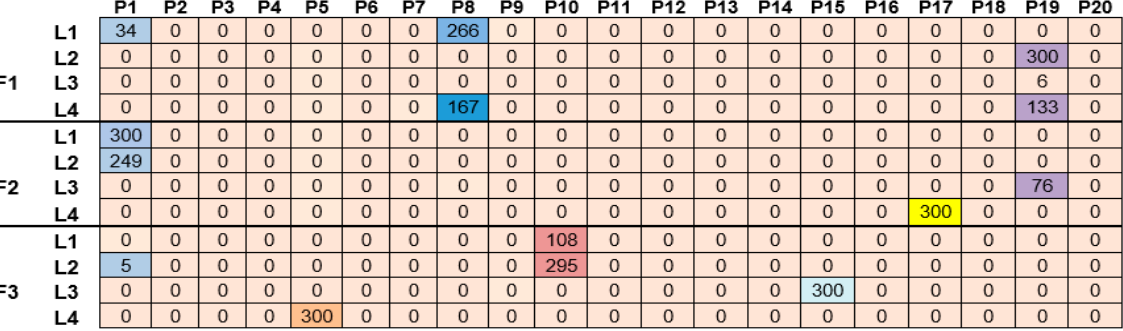
Figure 33. Allocated alternative crop successions to land unit under scenario II conditions (ha). Table 13. Comparison of optimized land allocation and attributes under different model scenario